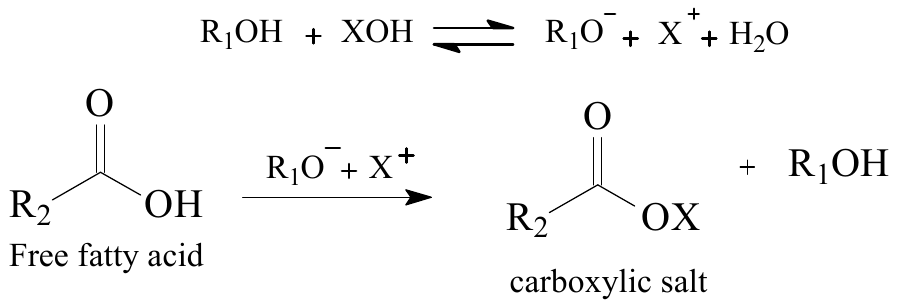
Figure 2. Saponification reaction of FFAs in basic medium. R 1 represents the alcohol chain and, X stands for the alkali, and R 2 is the FFAs chain.